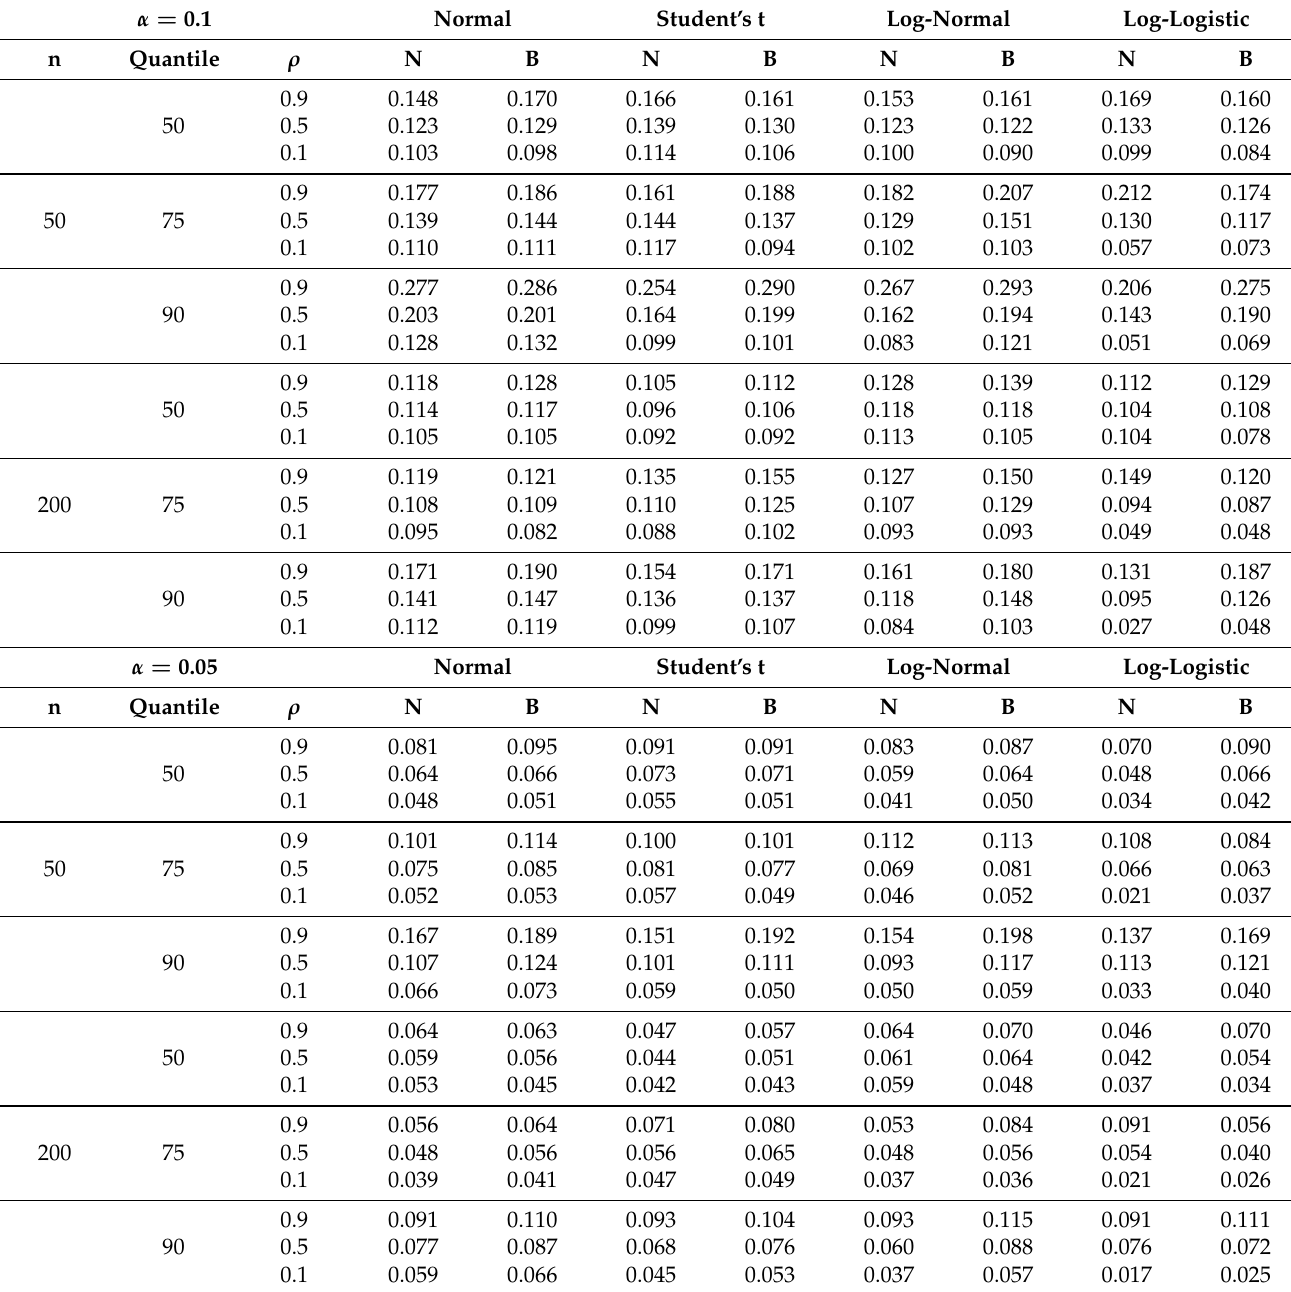
Table 3. Simulation results for local Moran statistic with medium number of neighbours